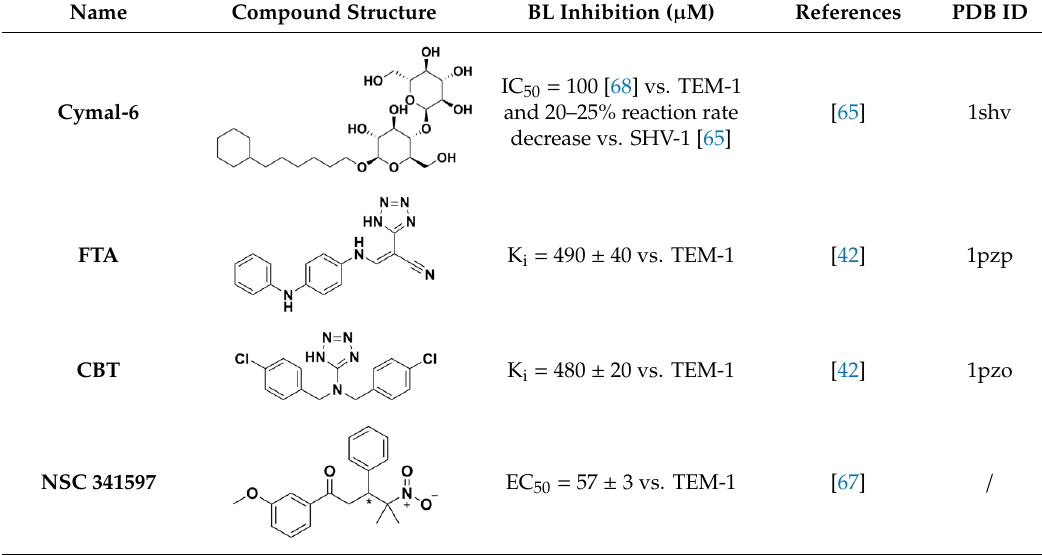
against class A BLs. Table 1. Summary table reporting name, structure, inhibition/activation profile and reference of class Table 1. Summary table reporting name, structure, inhibition/activation profile and reference of class A allosteric effectors. Stereochemistry has been explicitly indicated except for racemic mixtures, Table 1. Summary table reporting name, structure, inhibition/activation profile and reference of class A allosteric effectors. Stereochemistry has been explicitly indicated except for racemic mixtures, whose chiral centers have been marked by Table 1. Summary table reporting name, structure, inhibition/activation profile and reference of class A allosteric effectors. Stereochemistry has been explicitly indicated except for racemic mixtures, whose chiral centers have been marked by (*). A allosteric effectors. Stereochemistry has been explicitly indicated except for racemic mixtures, Table 1. Summary table reporting name, structure, inhibition / activation profile and reference of class A whose chiral centers have been marked by (*). whose chiral centers have been marked by (*). allosteric e ff ectors. Stereochemistry has been explicitly indicated except for racemic mixtures, whose chiral centers have been marked by (*).